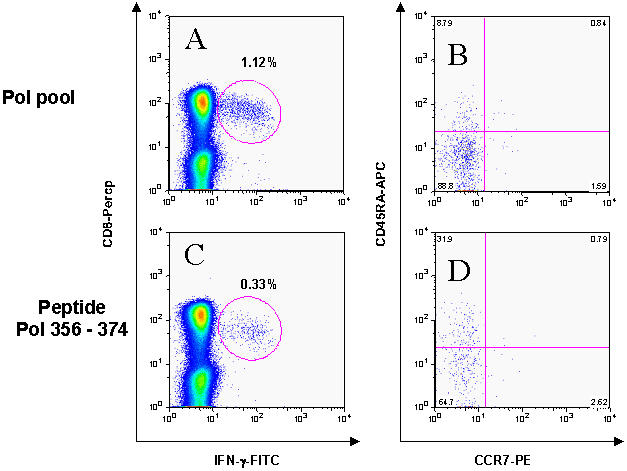
The effector phenotype of an individual CD8+T cell response may not be adequately reflected in a peptide pool.Panels A and C show IFN-γ production upon stimulation with the Pol peptide pool (A) and an individual Pol peptide (C). Panels B and D are gated on the IFN-γ producing cells and show differentiation phenotype of these HIV-1 specific cells as defined by CCR7 and CD45RA isoform. The terminally differentiated response to the Pol peptide 356–374 (31.9% CCR7−/CD45RA+ of gated cells) is diluted in the response to the entire Pol peptide pool (only 8.8% gated cells are CCR7−/CD45RA+).